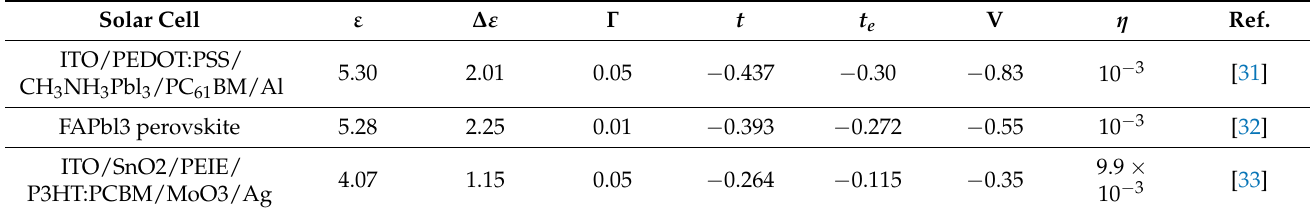
Table 1. Semiempirical parameters in eV used in Figure 4 with t h = t , W = V /2 and arbitrary U. Solar Cell ε ∆ ε Γ t t e V η